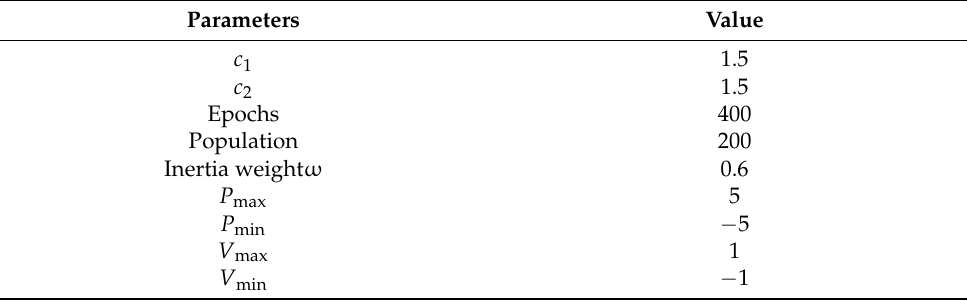
Table 5. PSO algorithm parameters.